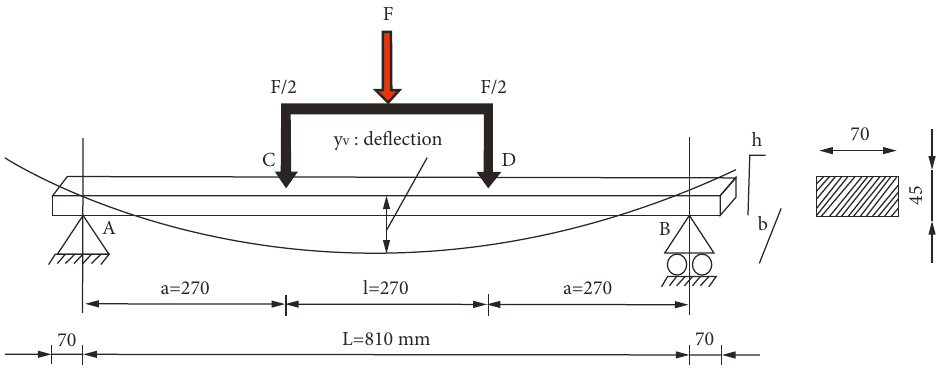
Figure 5: Schematic illustration of the flat 4-point bend test.